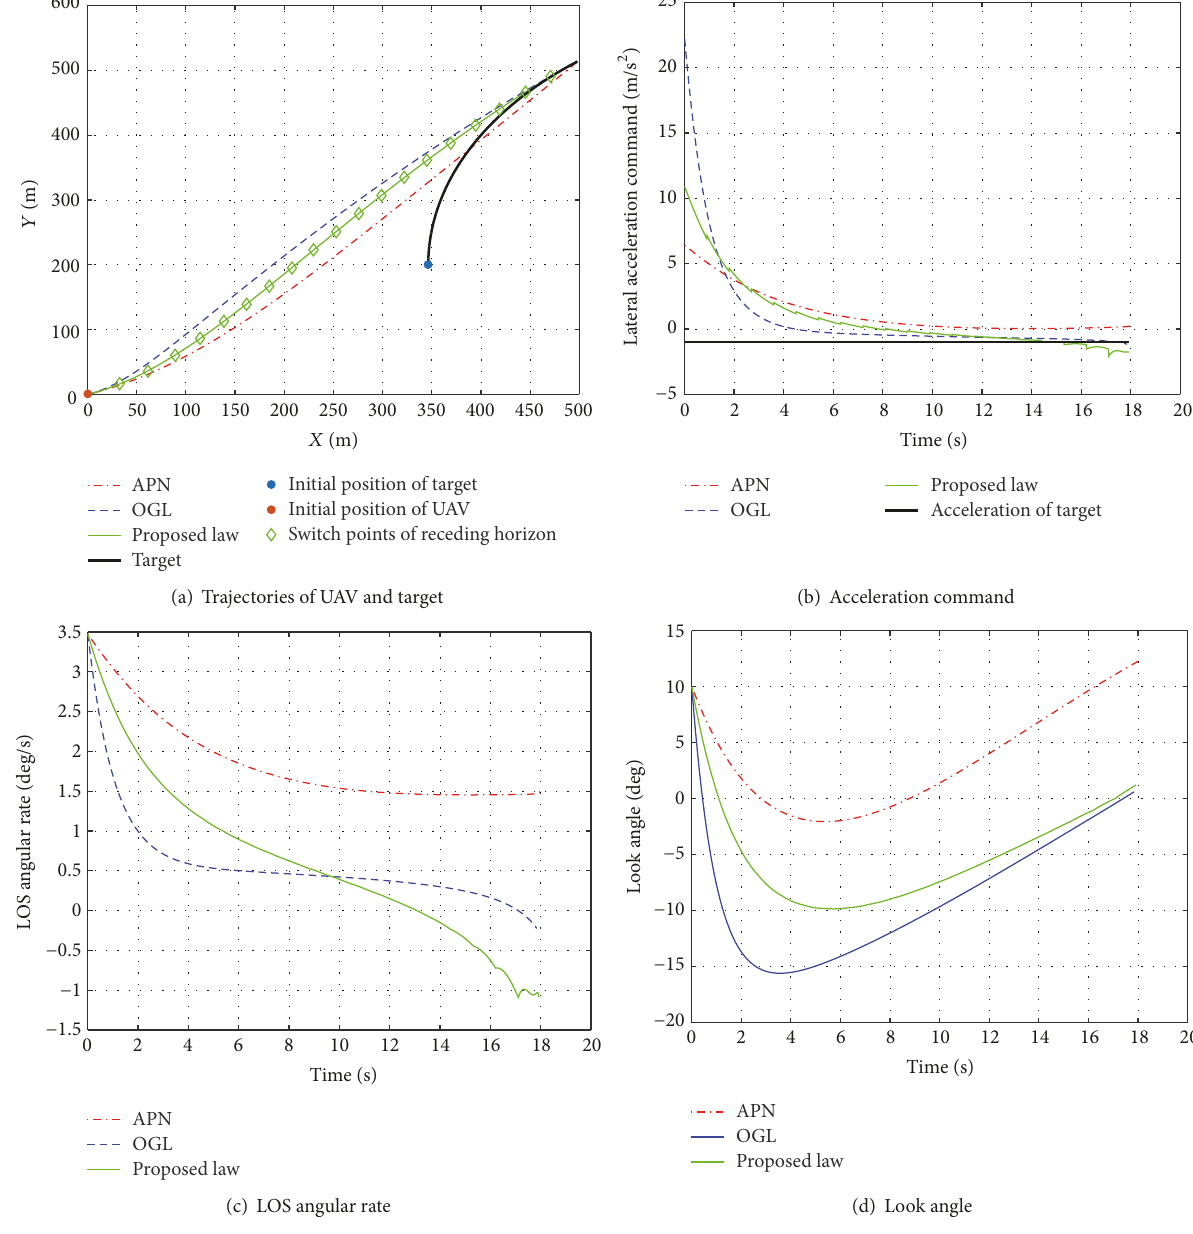
Figure 9: Responses in Case 2 (𝑎 𝑇 = −1 m / s 2 )